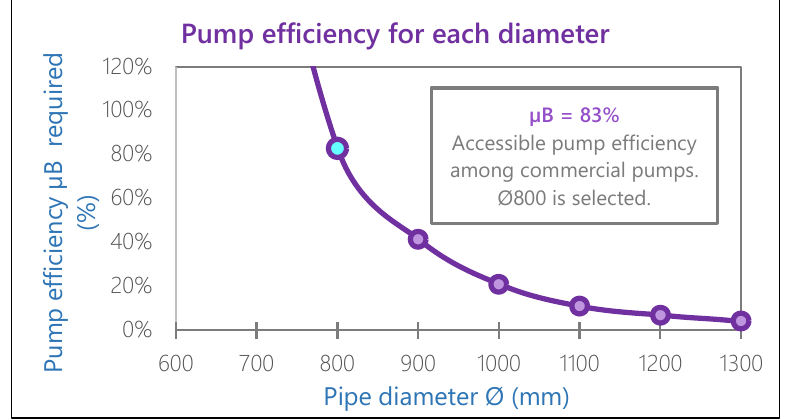
Figure 6. Pump efficiency required for each diameter. For the construction cost to be competitive with the energy cost, each pipeline designed with diameter ∅ requires a pump with a minimum efficiency of µ B . The smaller the pipe, the better (since the construction costs will be smaller), but the required µ B should be available in the market. Therefore, diameter ∅ 800 mm is selected since it is the smallest of the commercial catalog meeting realistic performance conditions.